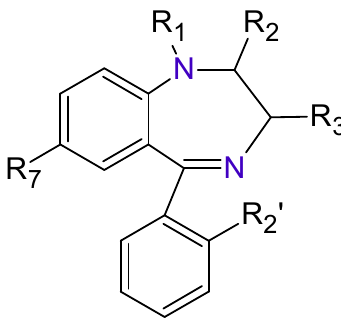
Figure 1. Benzodiazepines basic structure.